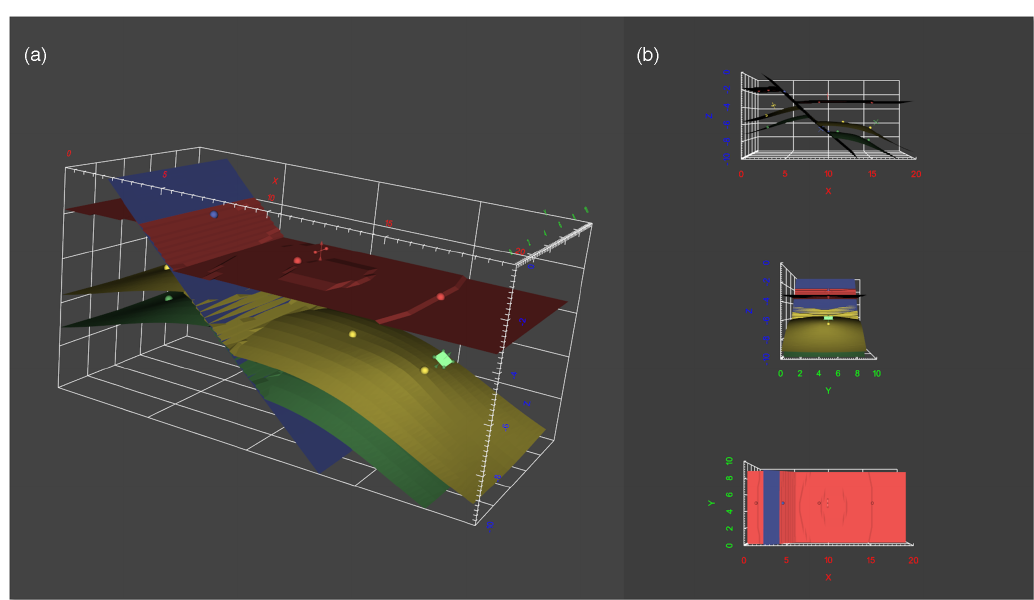
Figure 5. In-built vtk 3-D visualization of GemPy provides an interactive visualization of the geological model (a) and three additional orthogonal viewpoints (b) from different directions.